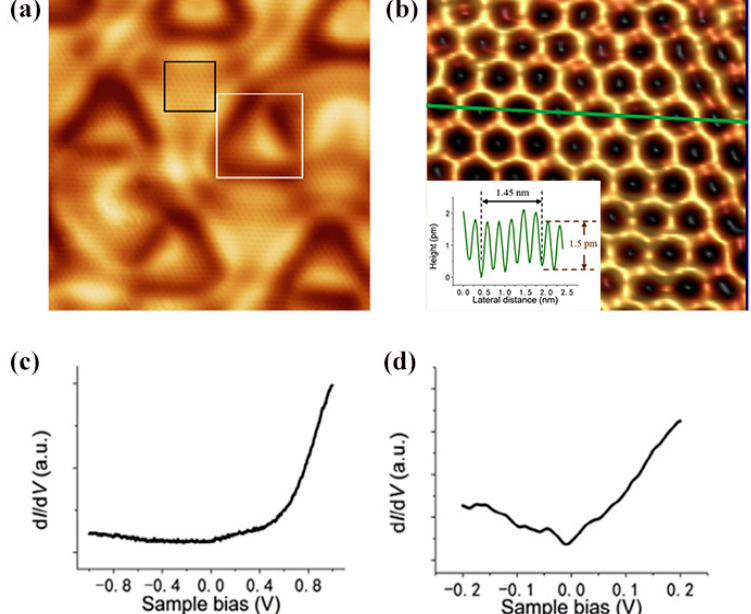
Figure 6. ( a ) STM image (15 nm × 15 nm) revealing the long-period configuration with triangular corrugation. ( b ) A high-resolution STM image (2.4 nm × 2.4 nm) of the area marked by the black rectangle in ( a ), showing a flat honeycomb lattice. Inset is a line profile along the green line. ( c , d ) The dI/dV curves taken on a borophene surface with a different bias voltage range. The scanning parameters for ( a , b ) are: sample bias − 11 mV, I = 130 pA [59]. Copyright 2018, Elsevier.